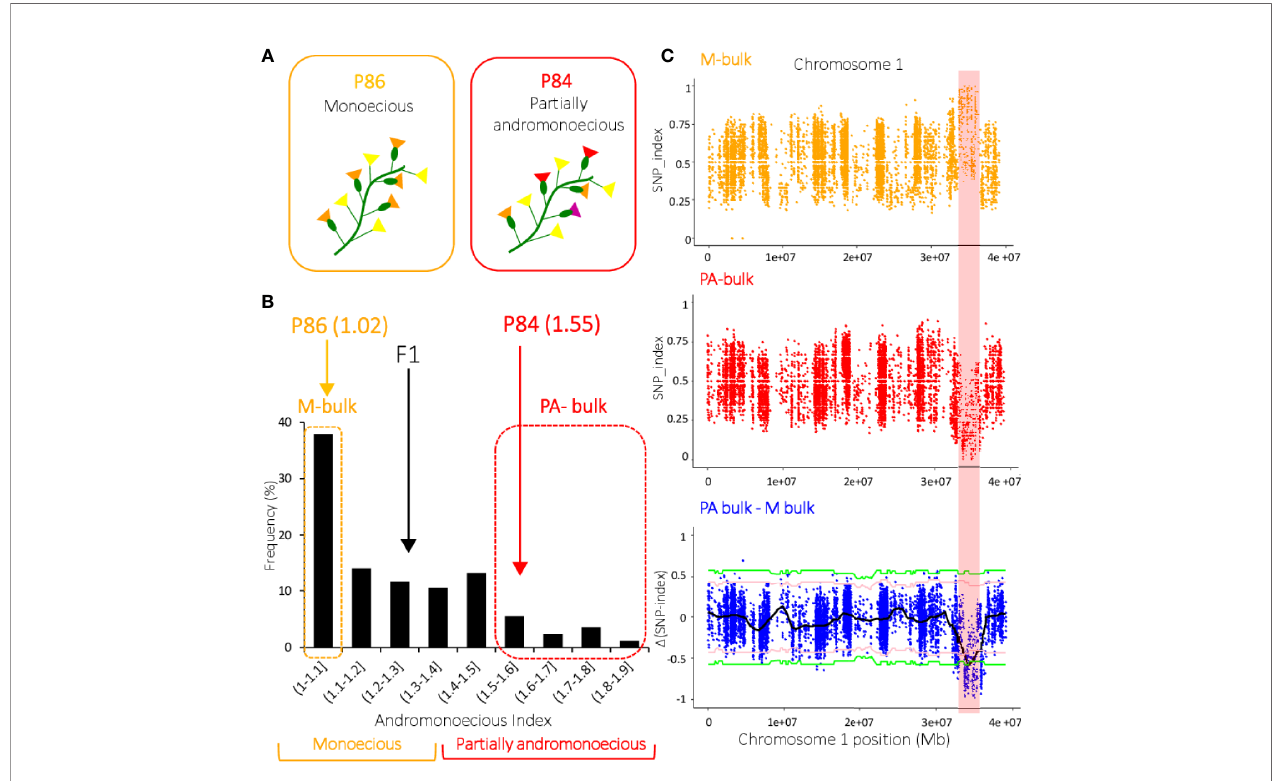
FIGURE 3 | QTL ‐ seq applied to watermelon F2 progeny identi fi ed the locus conferring partial andromonoecy ( pa ) on chromosome 1. (A) Phenotype of two watermelon inbred lines P84 and P86 for andromonoecy index. P84 is partially andromonoecious whereas P86 is monoecious. (B) Frequency distribution of andromonoecious index in 256 F2 progenies. The average andromonoecy index (AI) for P86 and P84 is indicated. The dashed orange and red boxes indicate the 20 F2 plants with AI=1 that were used to make the M-bulk, and the 20 F2/AI>1.6 plants used to make the PA-bulk. (C) SNP ‐ index plots of M ‐ bulk and PA ‐ bulk, and the D (SNP ‐ index) plot on chromosome 1. SNP-index was calculated based on a 1 Mb interval with a 10 kb sliding window. A candidate QTL on chromosome 1 (32.2 – 36.4 Mb interval) met the criteria that the SNP-index in M-pool was near 1, the SNP-index in PA-pool was near 0, and the D (SNP-index) was above the con fi dence value (P < 0.001). The D (SNP-index) plot shows the tricube smoothed Δ (SNP-index) and the statistical con fi dence intervals under the null hypothesis of no QTL (pink, P < 0.05; green, P <